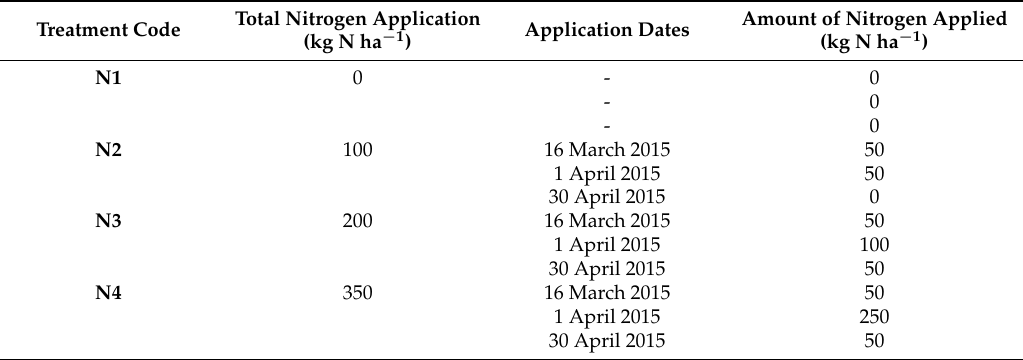
Table 1. Details of the four nitrogen fertiliser treatments applied to the diversity field experiment in 2015.